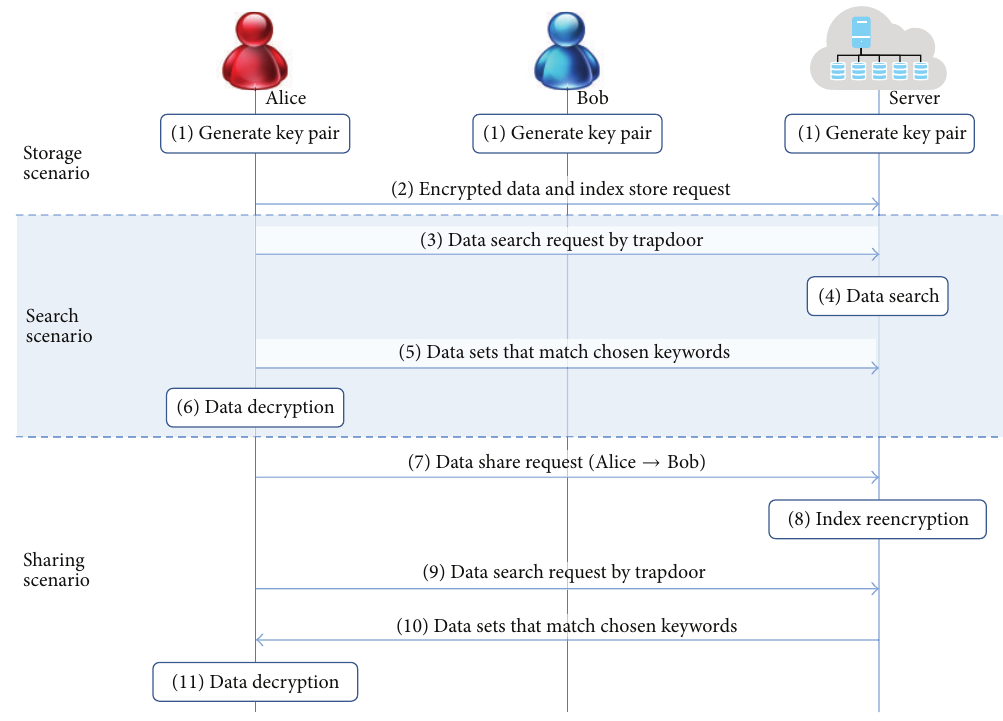
Figure 3: Flow chart of proposed